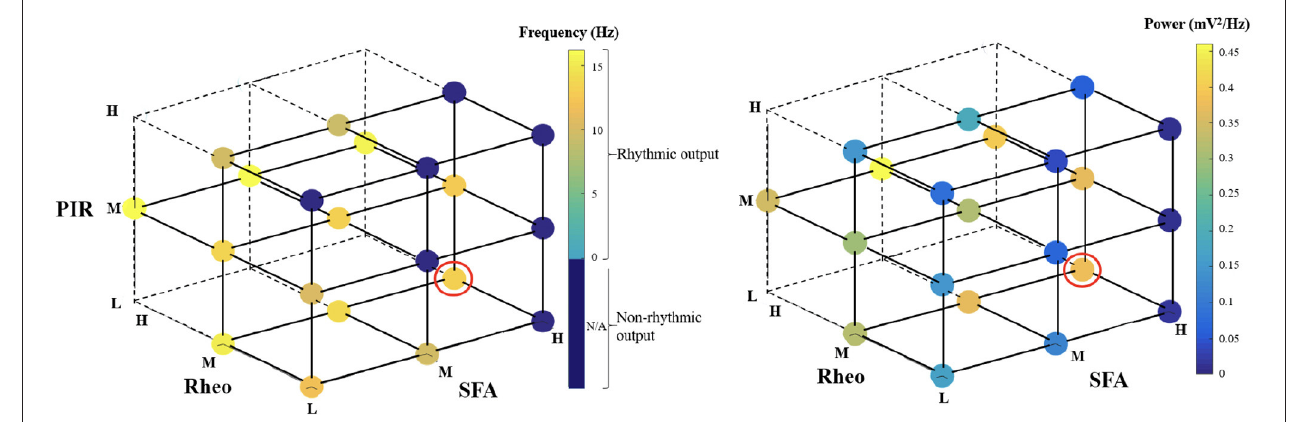
FIGURE 3 | Frequency and power of theta rhythms in heterogeneous E-I networks. Each dot represents the frequency (left) or power (right) of the output of the network that has [SFA,Rheo,PIR] features with a L, M, or H range of values as plotted, with the dot color representing the specific frequency or power value given in the color bar. The red circled dot is the network that has feature values that include base values for all of the features, i.e., [SFA,Rheo,PIR] = HML. The dark blue circles do not produce a rhythmic output, and the vertices that do not have any dots are where there were no individual PYR cell models to generate the particular heterogeneous network. Further details are provided in the Supplementary Material